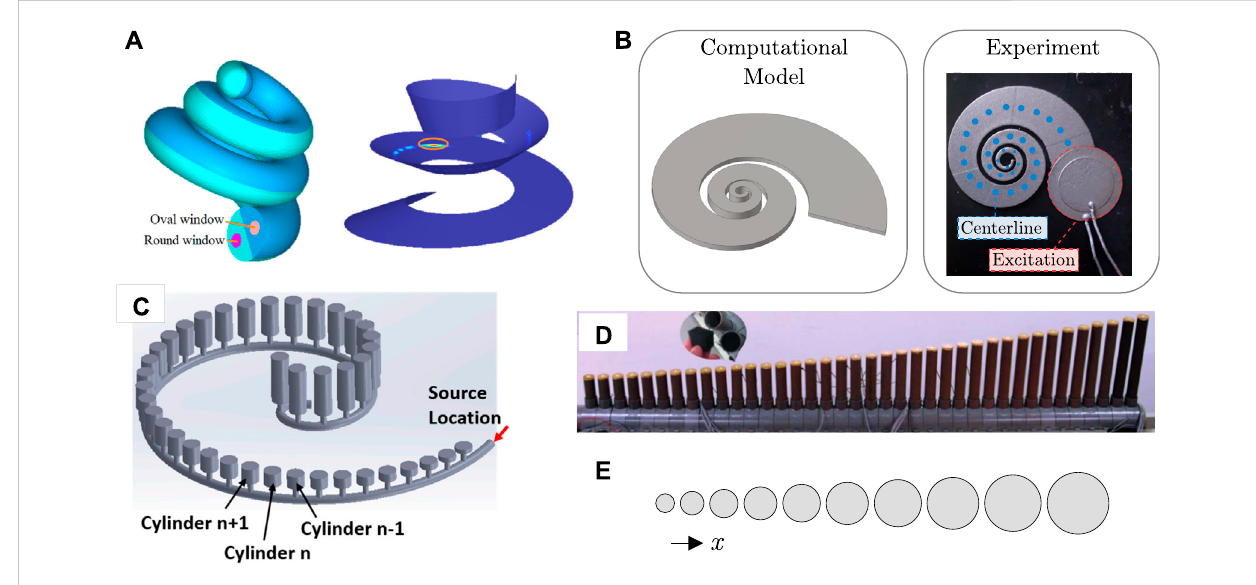
FIGURE 6 Systems mimicking cochleas and tonotopic properties. (A) Spiral locally resonant structure mimicking the cochlea (left), with a highlighted region correspondingtothemaximumvibration inthemembraneforagiven frequencyexcitation(right)[reprintedfrom(Maetal.,2014),withthepermissionof AIP publishing]. (B) Cochlea-inspired resonator with controlled curvature, width, and thickness variations (left). The out-of-plane vibration modes of this structure present a shift in their maxima from the outer to the inner region of the spiral along the centerline for increasing excitation signal frequencies (right) (Dal Poggetto et al., 2023). (C) Spiral array of graded Helmholtz resonators [adapted from (Zhao and Zhou, 2019)]. (D) Line array of graded quarter-wavelength resonators [adapted from (Rupin et al., 2019)]. (E) Array of graded resonators along the x direction with varying properties contrasting with the background (medium)